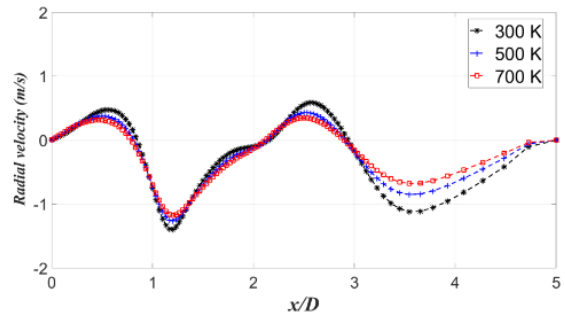
Figure 20. Axial velocity distributions at varied inlet temperatures.